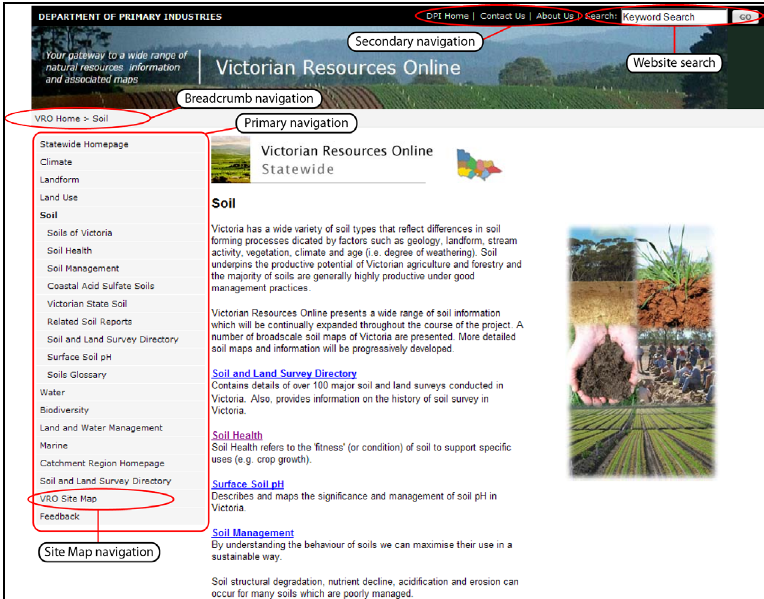
Figure 3. Range of navigation and search options on the VRO website.  State of Victoria, Department of Primary Industries 1997 Reproduced with